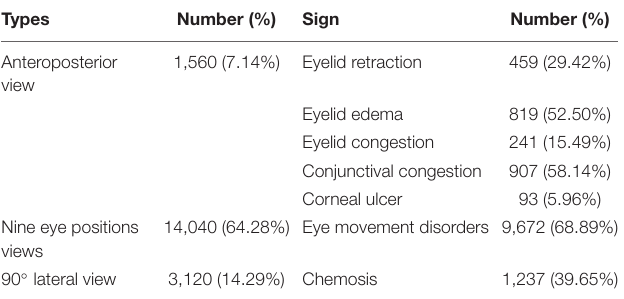
TABLE 1 | Patient image types.